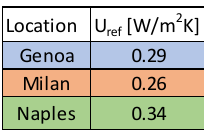
Figure 5. Thermal transmittance in cavity walls with different heat reflective insulating layers (in touch with one of the layers of bricks). The red, blue, and green lines represent the threshold for different cities. • Brick wall: the contribution provided by means of the heat reflective insulator to the existing/reduced insulating coating allows the limits to be respected independently from the material (Figure 6).